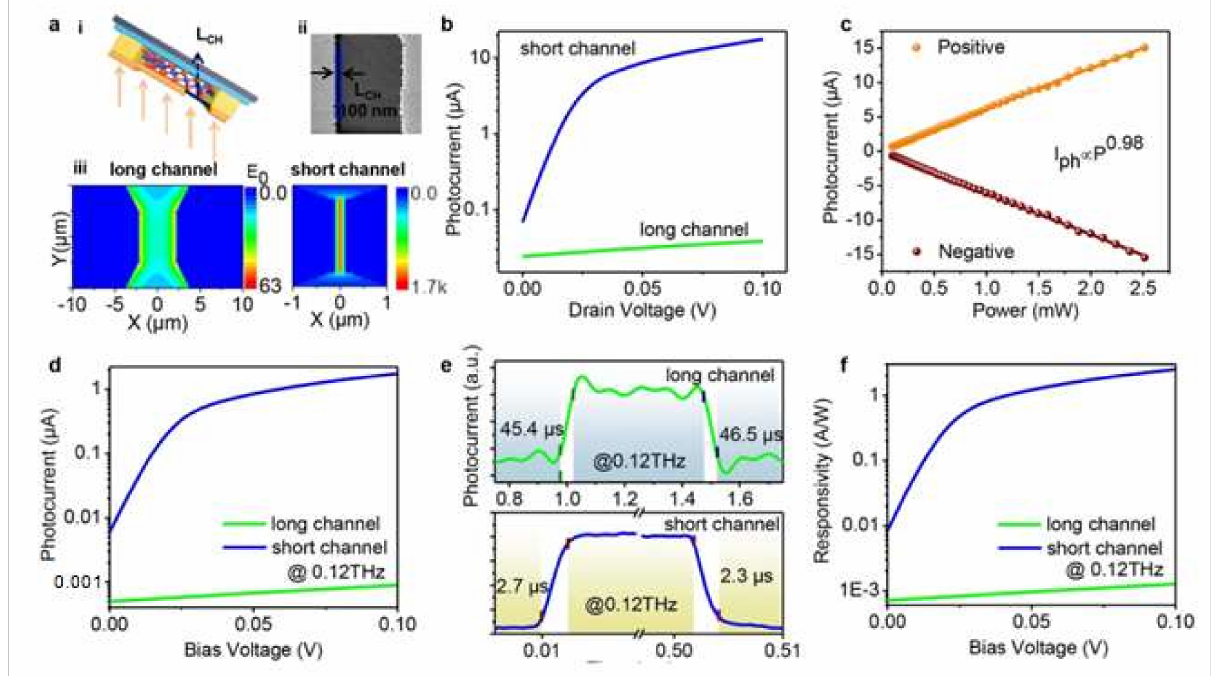
Figure 11. ( a i) Schematization of the realization of the short-channel device. ( a ii) Image of a short channel SnSe 2 -based photodetector acquired with the SEM. ( a iii) The electric field distribution of the SnSe 2 -based long channel (left panel) and short channel (right panel) photodetector. ( b ) and ( c ) Photocurrent as a function of the bias voltage and incident power at 0.04 THz, respectively. ( d ) Photocurrent as a function of bias voltage at 0.12 THz. ( e ) (top panel) Long channel and (bottom panel) short channel time-resolved photocurrent devices at 0.12 THz with 1 mW cm − 2 power. ( f ) Photoresponsivity vs. bias voltage at 0.12 THz with 1 mW cm − 2 power. Reproduced with permission from